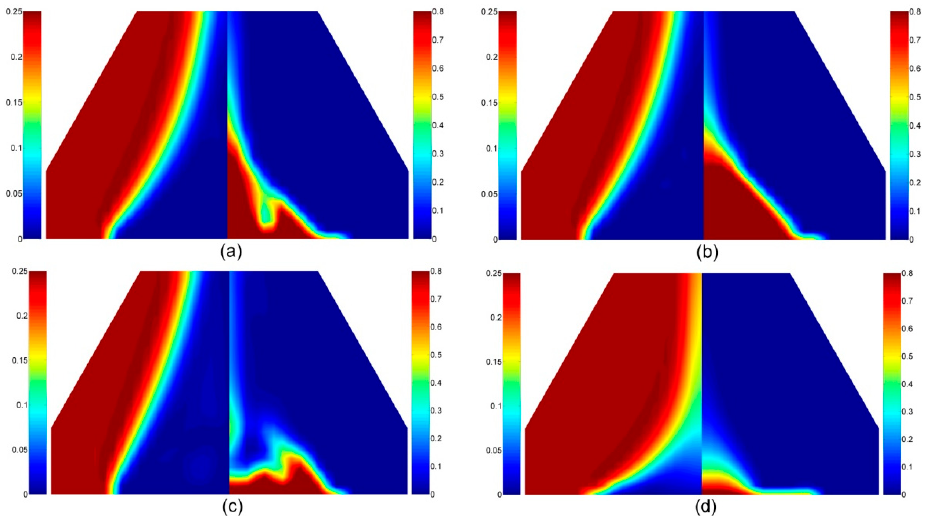
Figure 5. Mass fraction of O 2 (left half) and Fuel (right half) in gas phase for 10 mm thickness PMMA under 75 kW/m 2 heat flux at: ( a ) 100 s; ( b ) 200 s; ( c ) 300 s; and ( d ) 400 s.